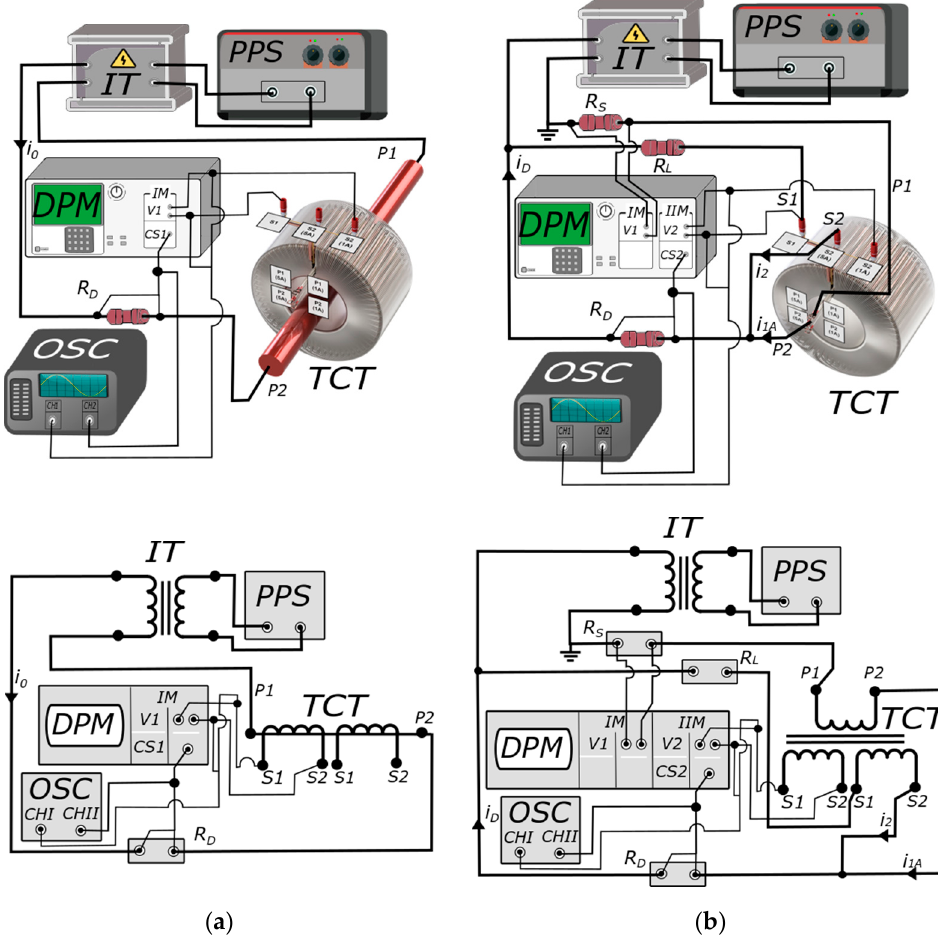
Figure 2. Measuring systems to determine the magnetization curves and the active power losses of the CT: ( a ) non-load state, ( b ) load state. the CT: ( a ) non-load state, ( b ) load